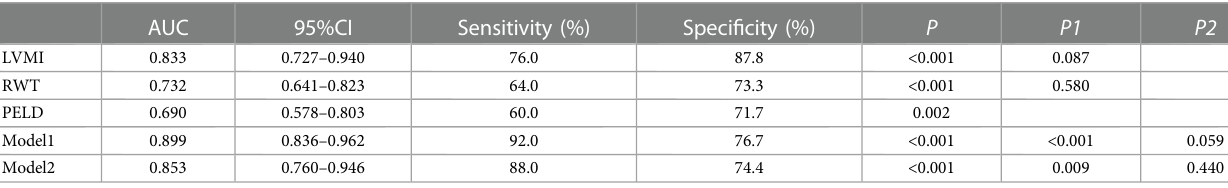
TABLE 3 Predictive performance among the different parameters and models.